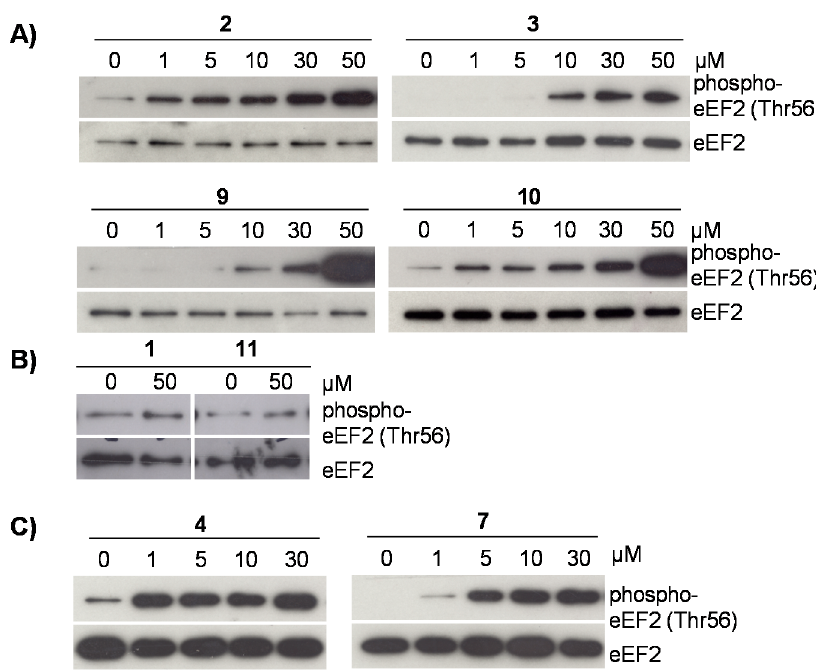
Figure 4. A – C Effect of flavonoids 1 – 4 , 7 , 9 – 11 on translational elongation. Phosphorylation of